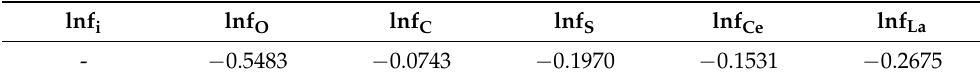
Table 4. Calculation results of the activity coefficients of the alloying elements.